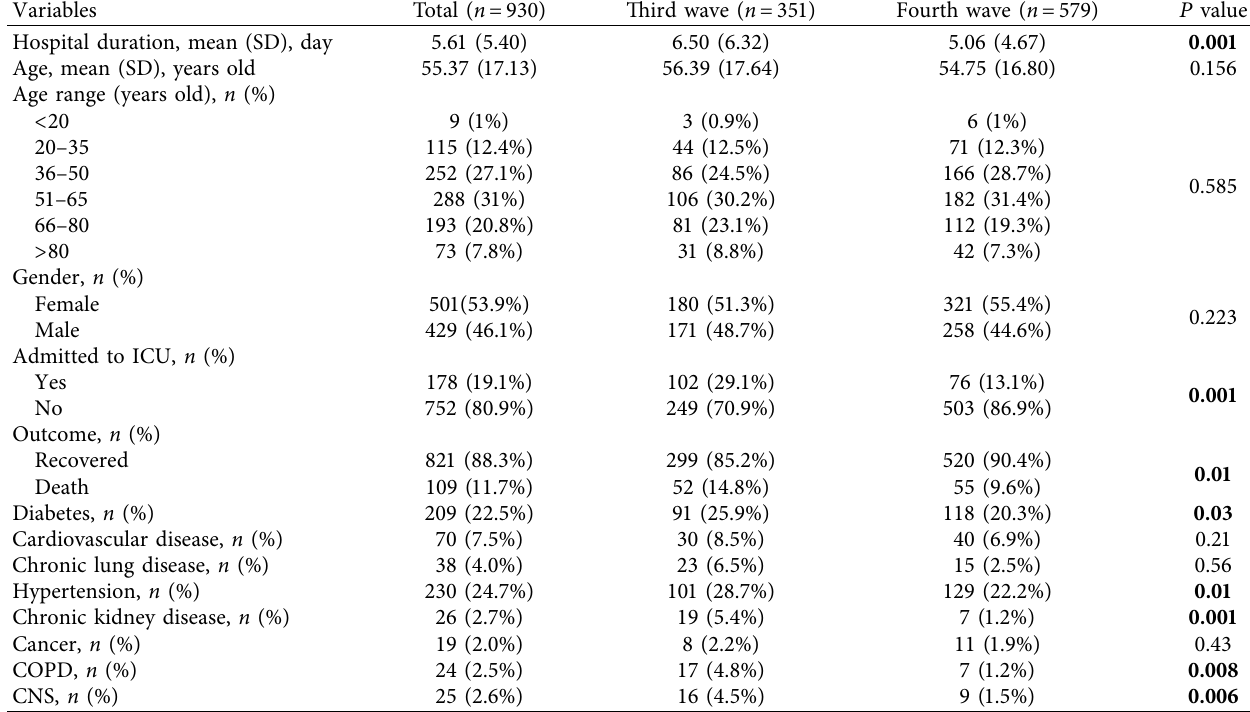
Table 1: Epidemiological and clinical characteristics among third and fourth wave COVID-19 cases.